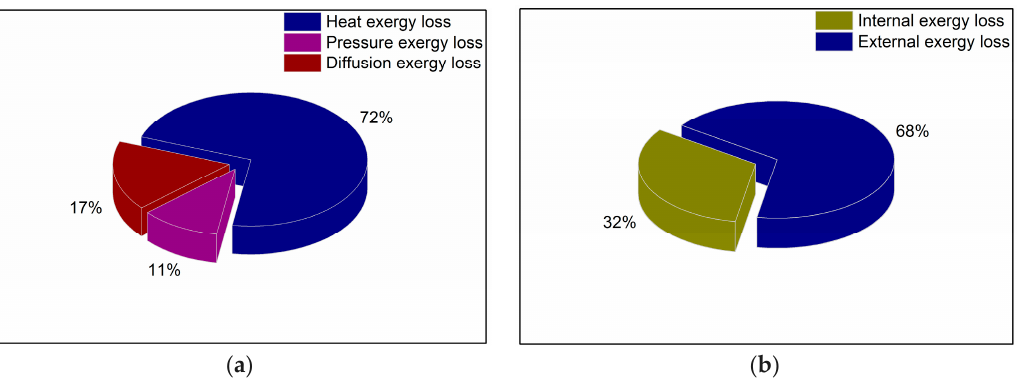
Figure 2. ( a ) The ratios of various exergy losses to total exergy loss; ( b ) The ratios of internal exergy loss and external exergy loss to total exergy